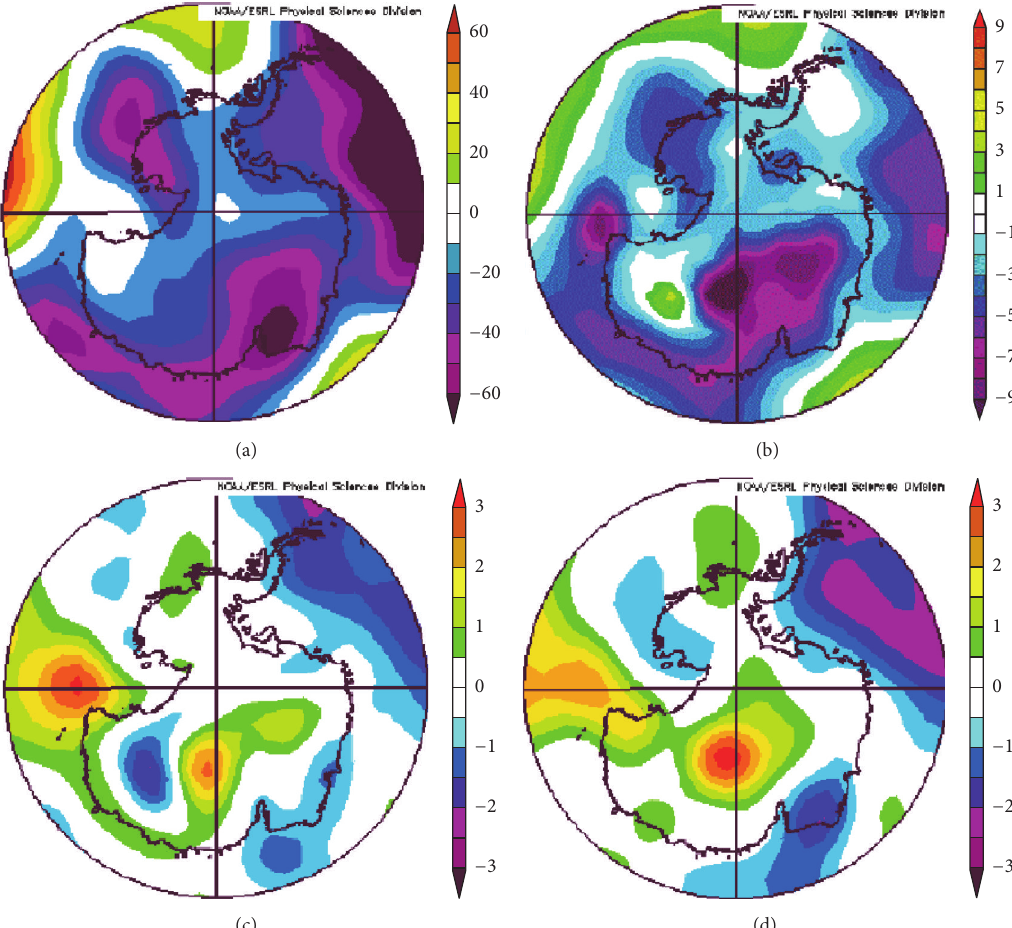
Figure 4: Mean anomaly fields over the detected 21 days with respect to the 40-year climatology: (a) 500 hPa geopotential height (gpm); (b) sea-level pressure (hPa); (c) 850 hPa air temperature (k); (d) 500 hPa air temperature (K) (source: http://www.esrl.noaa.gov/psd/data/com-